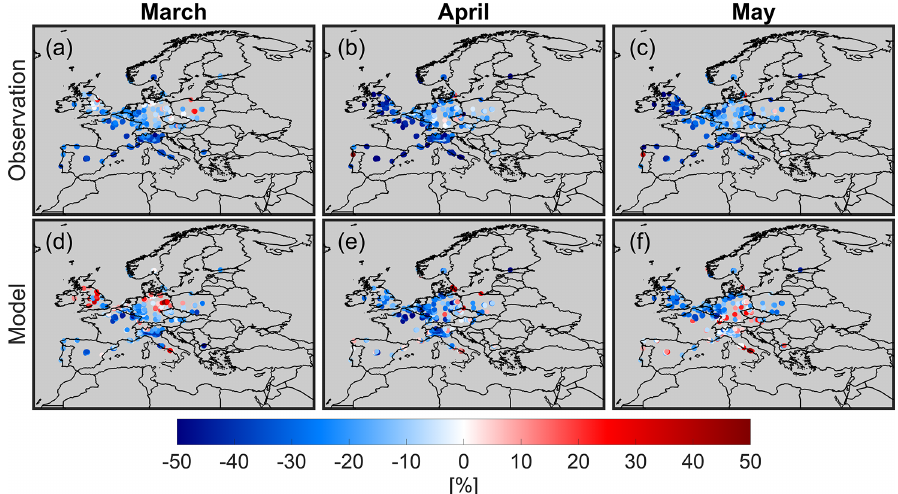
Figure 4. Scatter maps of relative changes in surface NO 2 concentrations suggested by the European air quality network (a, b, c) , and the constrained model (d, e, f) . Results are daily averaged. We only consider grid cells whose averaging kernels (from the NO x inversion) are above 0.5. Furthermore, grid cells having more than two stations are only included to partly account for the spatial representativity factor. Surface concentrations are not accounted for the NO z family